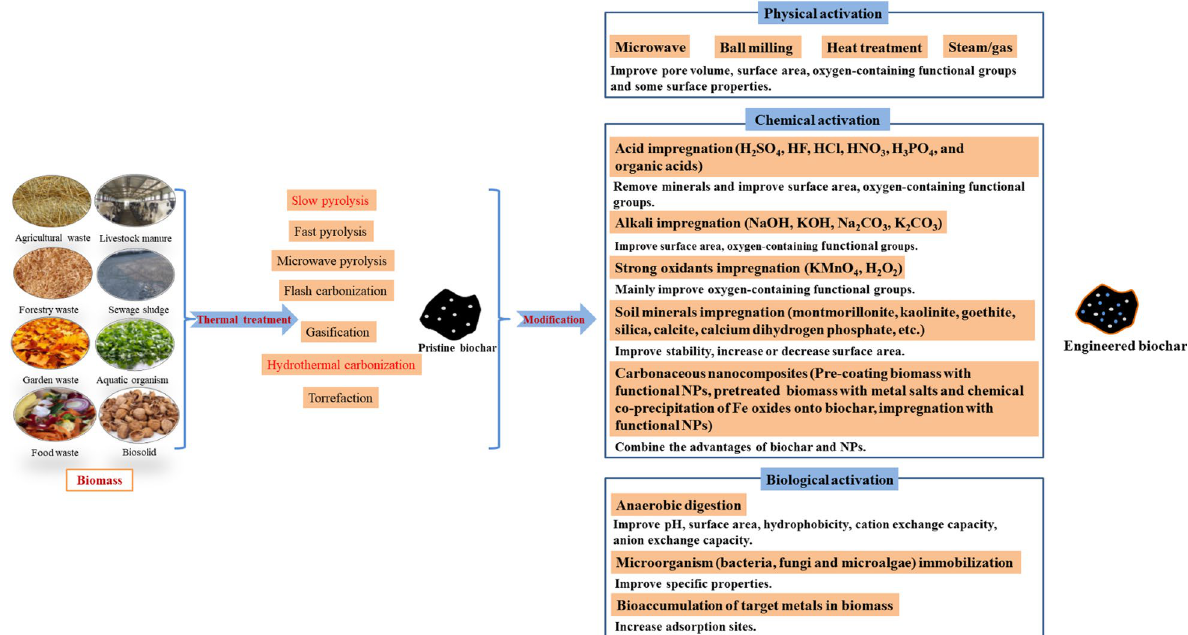
Fig. 1 Biochar production and modification. Modified from Wu et al.